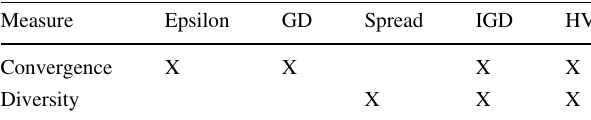
Table 2 Quality indicators with regard to convergence and diversity Measure